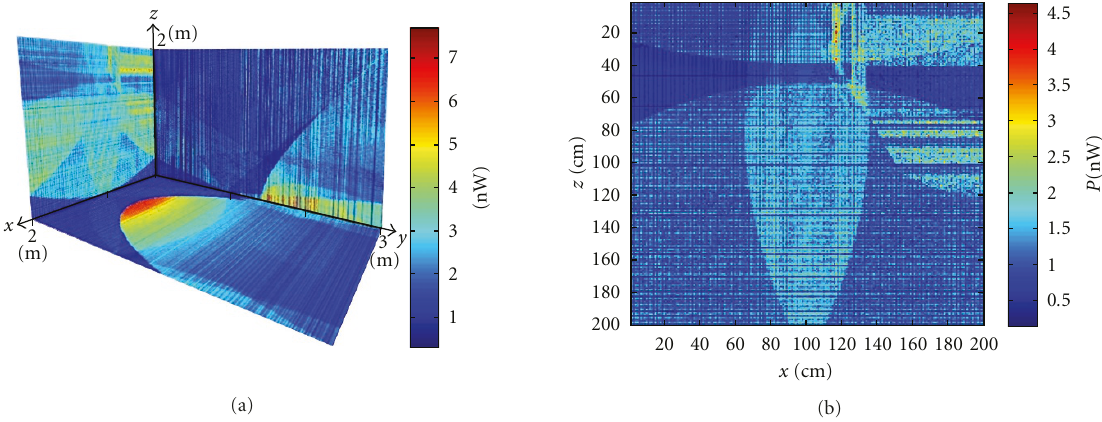
Figure 5: The surface power distributions with rays tracing up to 5 reflections for (a) three walls and (b) one wall.